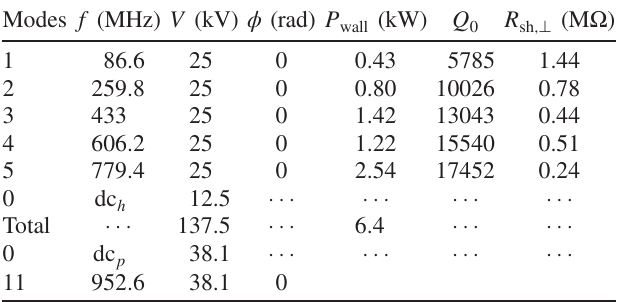
TABLE II. Figures of merit for a harmonic kicker cavity. The middle box is for the harmonic kicker and the bottom box is for the pre/post kicker. n is harmonic number, f is frequency, V is h kick voltage amplitude, and ϕ is rf phase. P is wall loss, Q 0 is wall unloaded quality factor, and R is the transverse shunt sh ; ⊥ impedance of the harmonic kicker. dc and dc refer to dc h p magnet field associated with harmonic kicker and pre/post kicker and kick voltage translates to 0.1 and 0.3 mT for a 0.4 m long magnet,